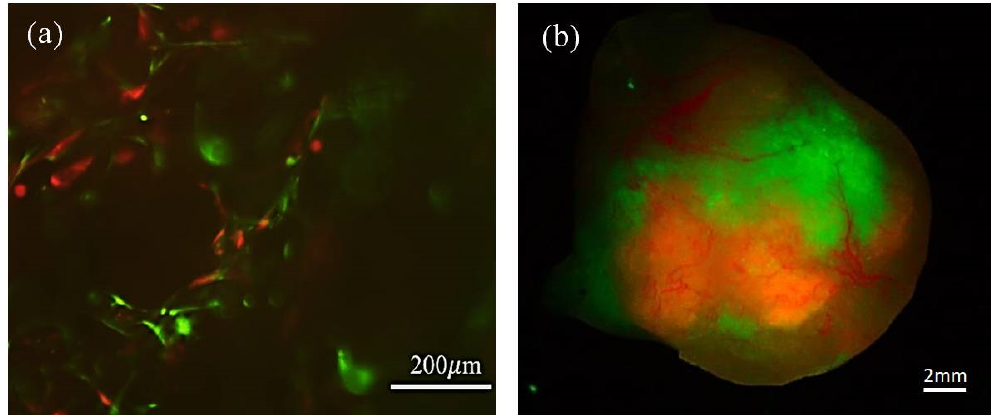
Figure 3. Persistence of tumor stromal cells in bioengineered SCC following protocols 1 and 2, respectively. ( a ) In vitro fluorescence microscope image from the cell culture, before transplantation, where both the EGFP-CAFs and RFP-SCC-keratinocytes are observed; scale bar: 200 µ m. ( b ) In vivo3D fluorescence image obtained from the tumor, 8 weeks after implantation, using XLView Loupe. Scale bar: 2 mm.